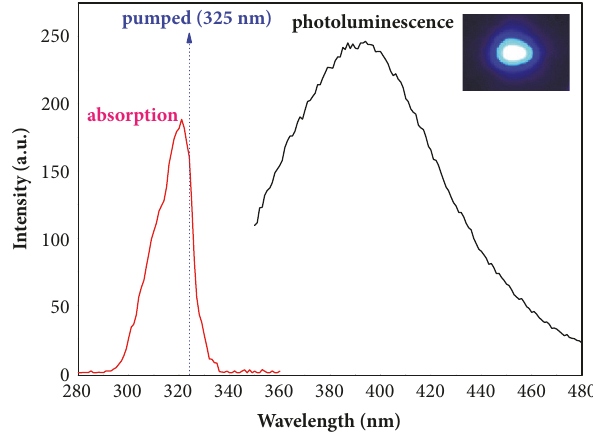
Figure 2: The experimental absorption and fluorescence emission spectra of the pure NLCs cell and the image of the fluorescence emission under the pumped helium-cadmium laser operated at